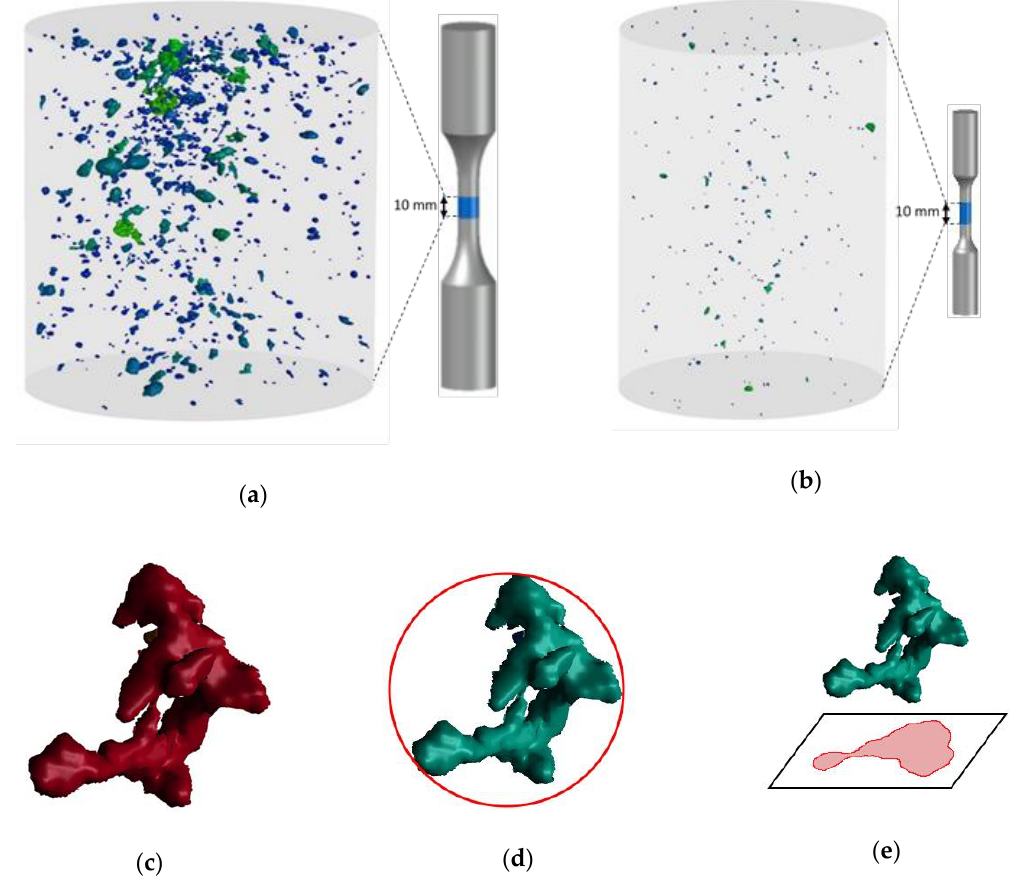
Figure 3. Examples of 3D images of defects in ( a ) large specimens, ( b ) small specimens, three different defect parameters characterizing the defects size, ( c ) volume of the defect ( √𝑉𝑜𝑙𝑢𝑚𝑒 3 ), ( d ) max Feret diameter ( 𝐹𝑒𝑟𝑒𝑡 𝑚𝑎𝑥 ), and ( e ) area of the projected area on the plane perpendicular to the specimen axis ( √𝐴 𝑝𝑟𝑜𝑗𝑒𝑐𝑡𝑒𝑑 ).